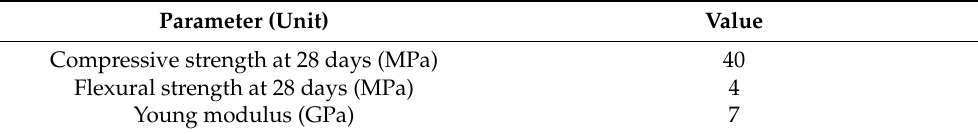
Table 2. Mechanical properties of mortar used in the PBO-FRCM composite system.